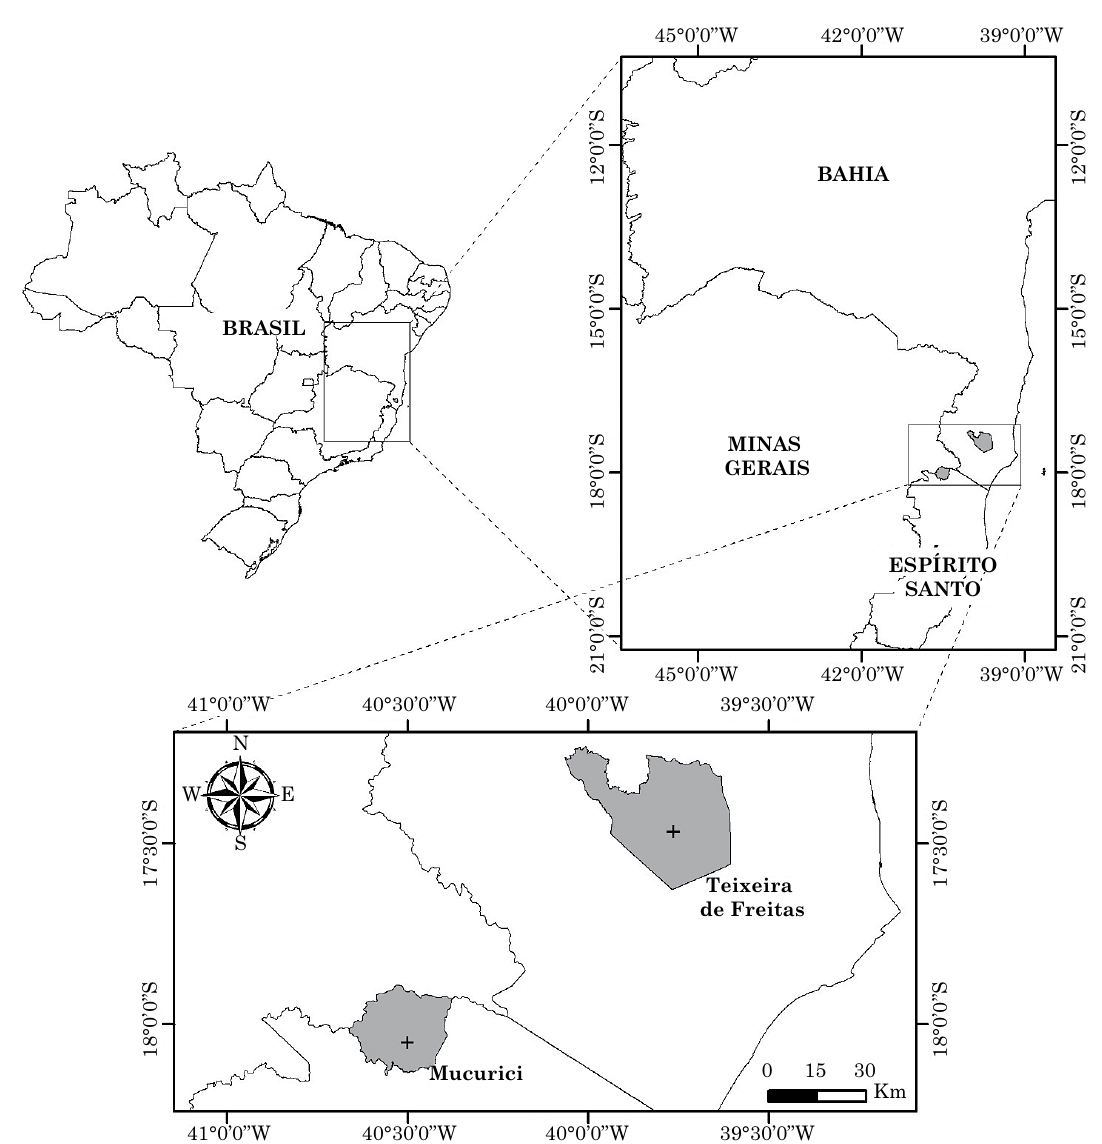
Figura 1. localização dos municípios de coleta das topossequências